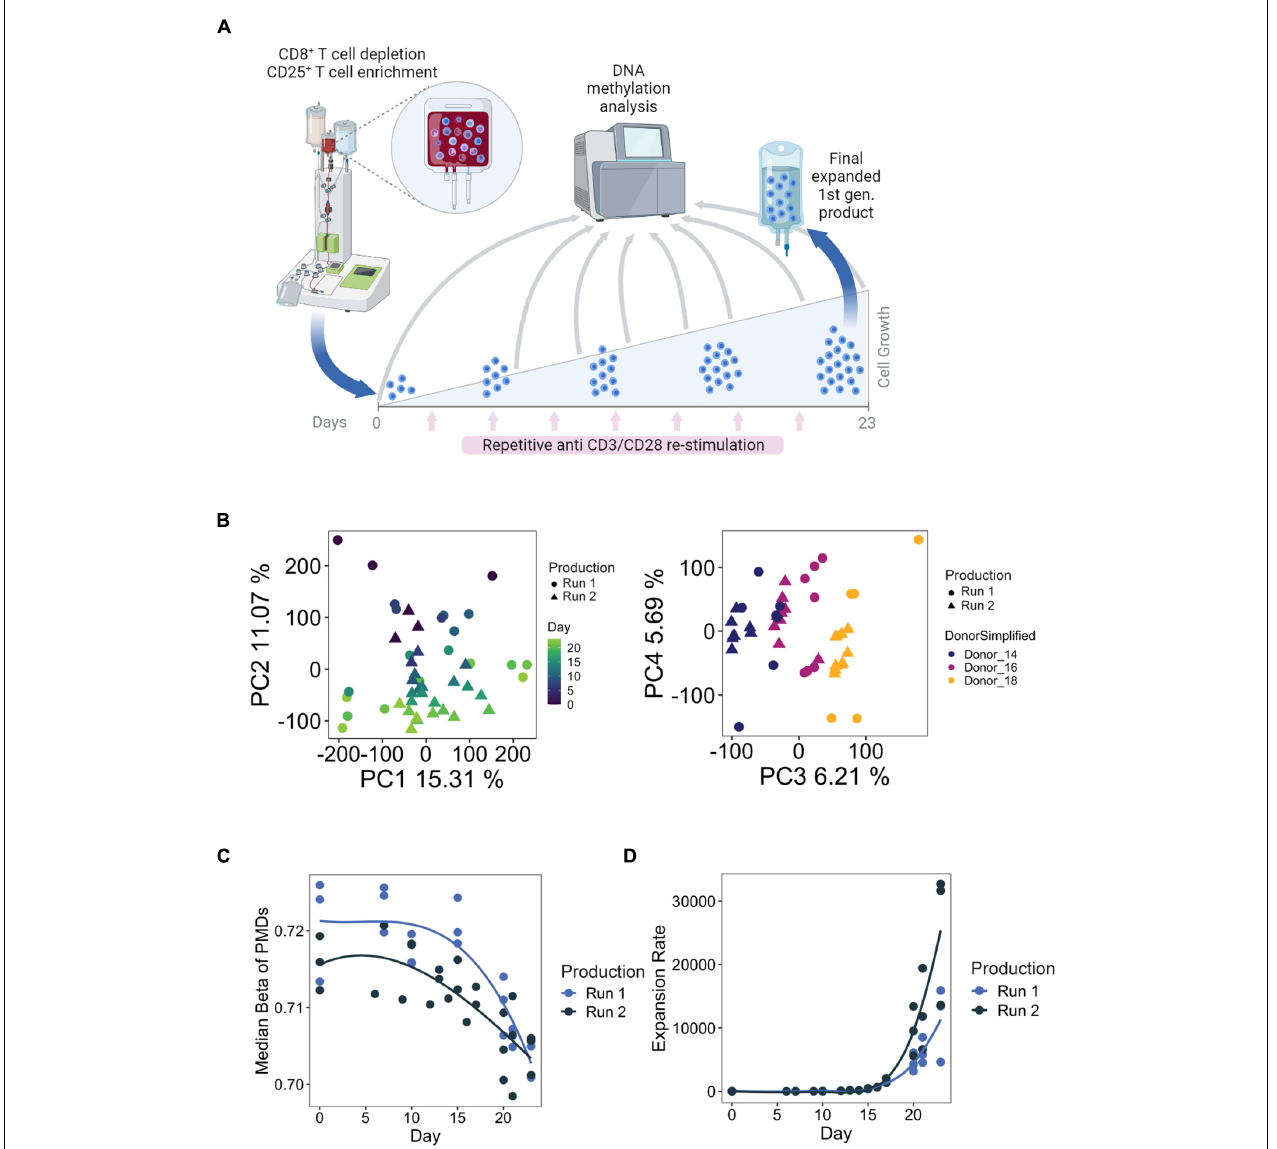
FIGURE 1 | (A) Example manufacturing run for first-generation Treg products. Briefly, Tregs were enriched through CD8 + depletion followed by CD25 + enrichment using the CliniMACS R (cid:13) system from whole blood. Tregs are cultured over the course of 23 days, with 8 total stimulations with anti-CD3/CD28 microbeads. Time points used for DNA methylation analysis are indicated with the gray arrows. Figure created with BioRender.com. (B) PCA analysis of samples taken from all available time points from both manufacturing runs. (C,D) Median methylation values of partially methylated domains (PMDs) (left) and cumulated expansion rate (right) during Treg product